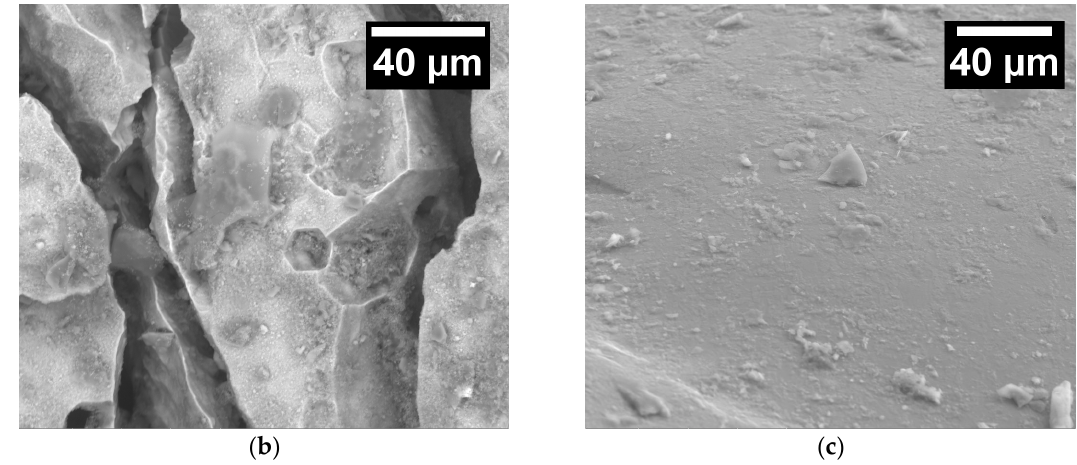
Figure 3. Scanning electron microscope (SEM) micrographs of ( a ) pyrite at week 0 (45 wt % Fe and 55 wt % S); ( b ) pyrite from the Control KLC at week 84 (17 wt % O, 44 wt % Fe, 6 wt % Si and 34 wt % S) and ( c ) pyrite from the BS + CSW KLC at week 84 (20 wt % O, 19 wt % Fe, 8 wt % Si and 53 wt % S).